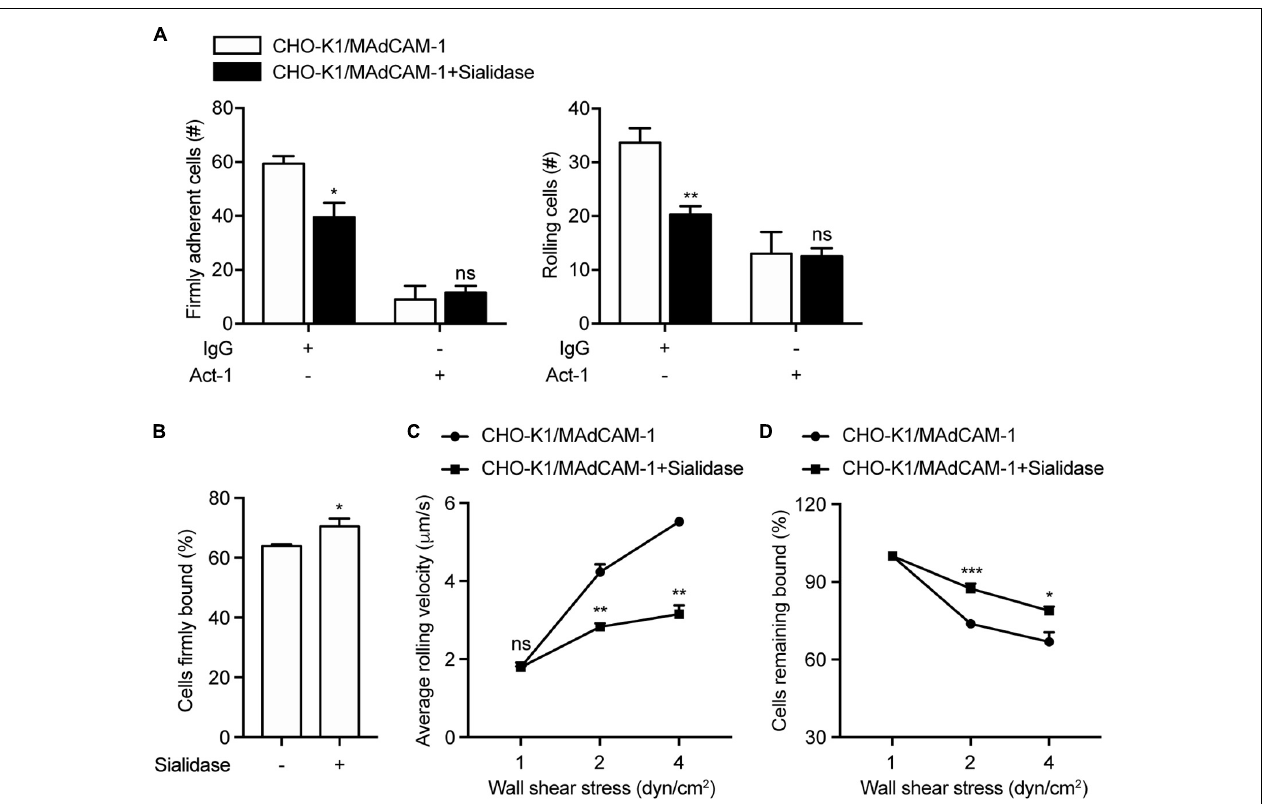
FIGURE 3 | Breaking the negative charges of the extracellular microenvironment suppresses integrin α 4 β 7-mediated cell adhesion. Adhesive behaviors of 293T- α 4 β 7 cells on CHO-K1/MAdCAM-1 cells. (A) The number of rolling and firmly adherent 293T- α 4 β 7 cells was measured at a wall shear stress of 1 dyn/cm 2 . Cells were pre-treated with murine IgG (10 µ g/ml) or α 4 β 7 blocking antibody Act-1 (10 µ g/ml) for 10 min at 37 ◦ C. (B) Percentage of cells firmly bound to CHO-K1/MAdCAM-1 cells at a wall shear stress of 1 dyn/cm 2 . (C) Average rolling velocity of 293T- α 4 β 7 cells that adhered to CHO-K1/MAdCAM-1 cells at indicated wall shear stresses. (D) Resistance of 293T- α 4 β 7 cells to detachment at increasing wall shear stresses. One representative result of three independent experiments is shown. Data represent the mean ± SEM ( n ≥ 3). * p < 0.05, ** p < 0.01, *** p < 0.001, ns: not significant (Student’s t